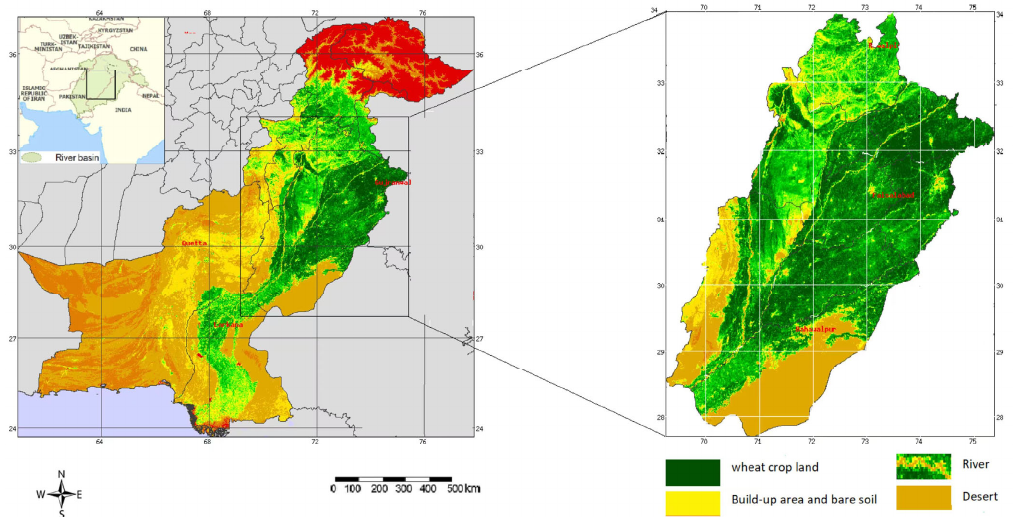
Figure 1. The geographic location of Pakistan and the selected study region representing wheat cropland, rivers, build ‐ up area, bare soil, and desert spread over h23/v05, h24/v05, and h23/v06 plates, defined as (27.41–34.02°N, 69.15–75.23°E) over the region of Punjab Pakistan.